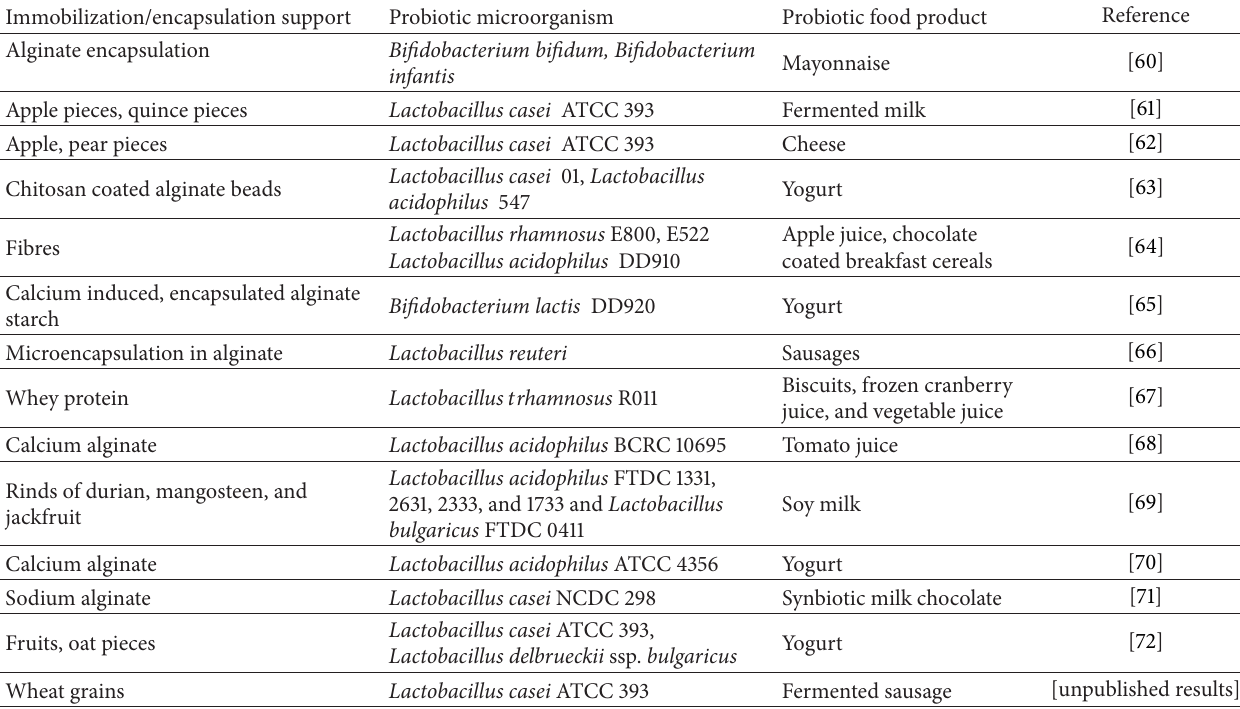
Table 5: Characteristic examples of application of probiotic cell immobilization in food